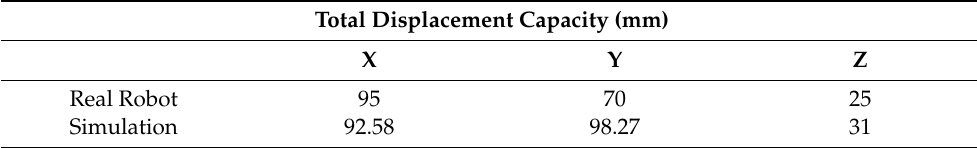
Table 4. Total displacement of the free end of the robot. Source: